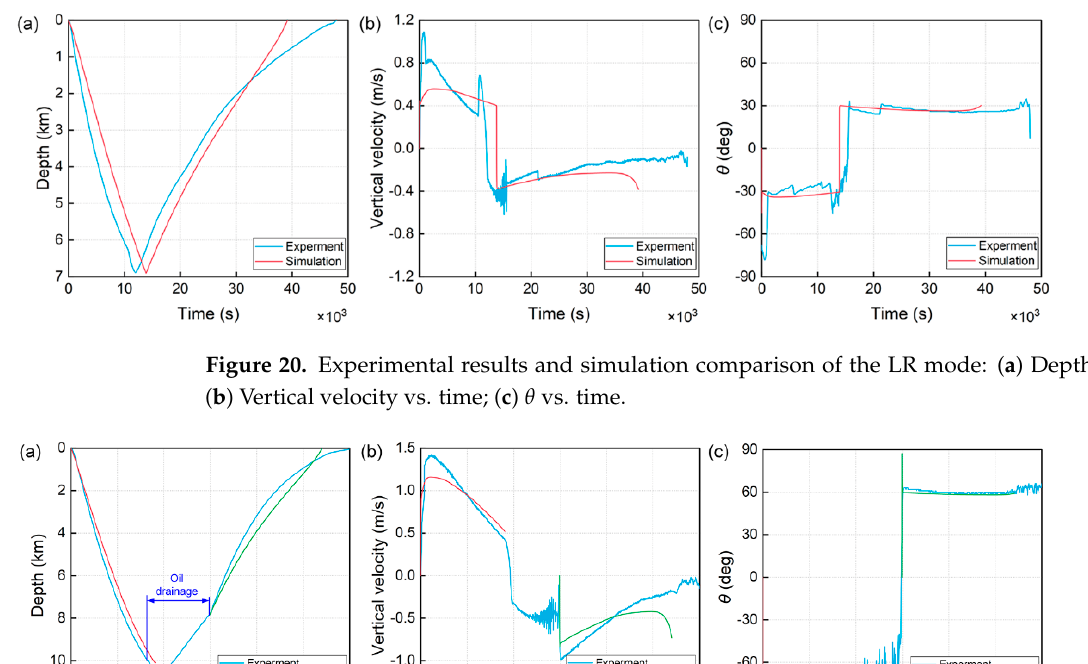
21 of 25 Figure 19. Sea trial of Petrel-X PLUS in Mariana Trench: ( a ) Sea trial area; ( b ) Petrel-X PLUS in the sea trial; ( c ) The navigation trajectory. The comparison between the experiments and simulations in LR and VM modes is shown in Figures 20 and 21, respectively. The experimental profile in LR mode dives to a depth of 6889 m with x r values of − 0.433 m (descent), − 0.403 m (ascent), and λ 1 = − λ 2 = 0° (descent and ascent). The experimental profile in VM mode dives to a depth of 10,619 m with x r values of − 0.358 m (descent), − 0.478 m (ascent), and λ 1 = − λ 2 = 90° (descent and ascent). Note that the non-stationary process due to oil drainage is ignored in the simula- tion of VM mode, as the duration of the process is approximately 2 h [42]. In general, the results of the simulations and experiments are in good agreement, while the navigation times of the experimental profiles are longer than those of the simulations. This is because the simulations did not consider the disturbance caused by actual ocean currents, which